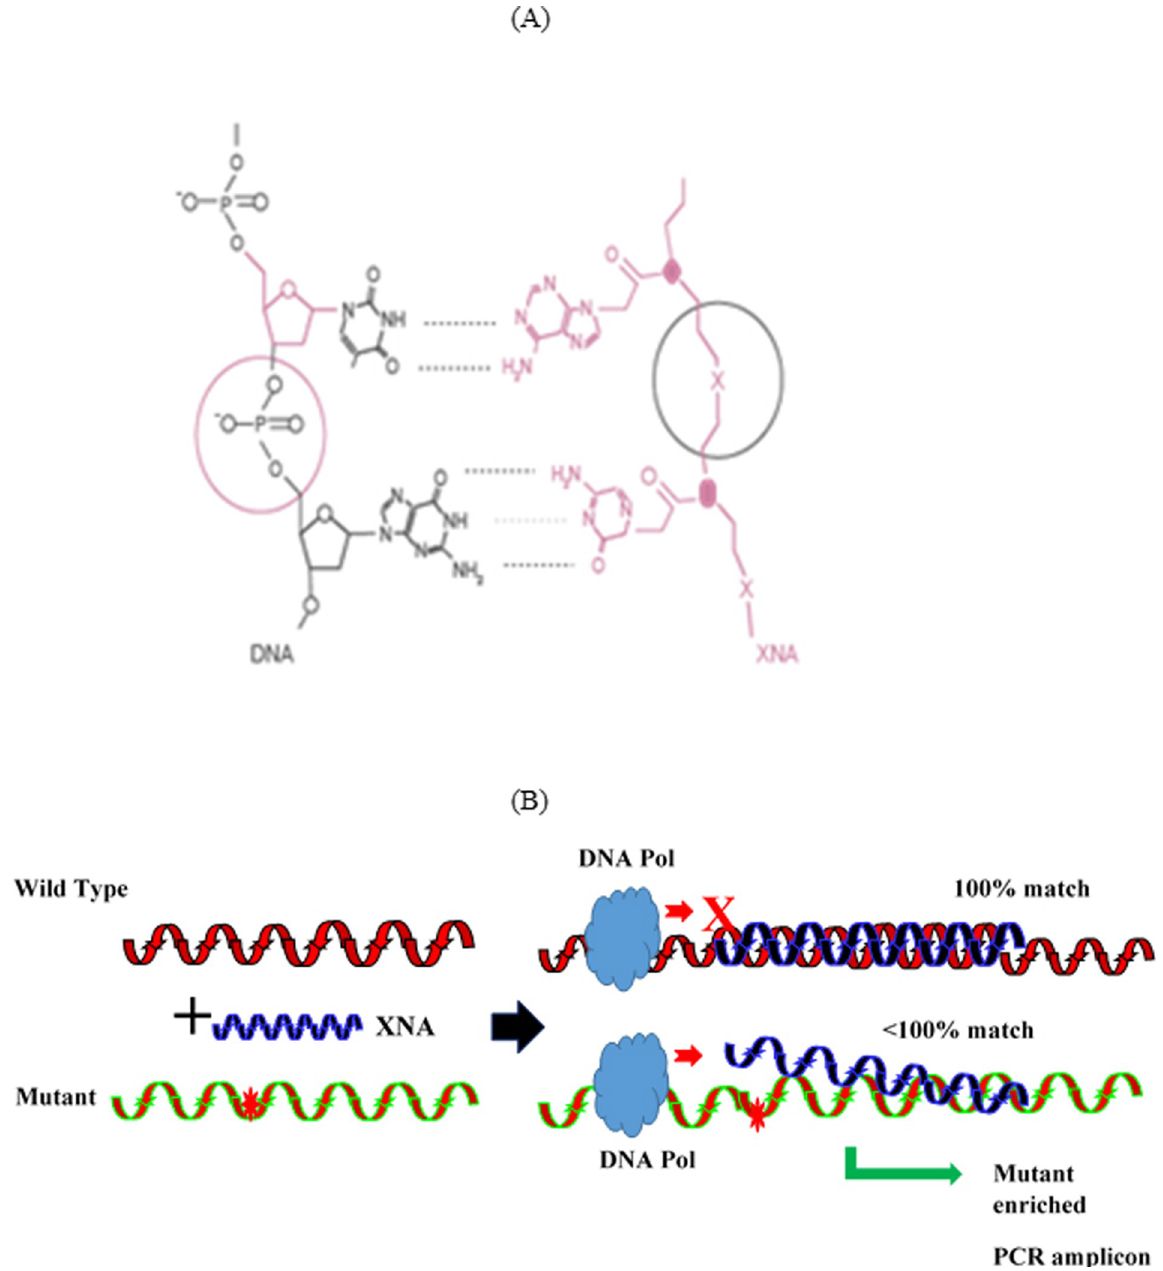
Fig 1. XNA structure and its function in the assay. (A). XNA structure and hybridization with DNA. (B). Principle of the Coloscape TM assay mutation detection in targeted genes. XNAs hybridize tightly to complementary DNA target sequences only if the sequence is a complete match. When there is a mutation in the target site, and therefore is a mismatch, the XNA: DNA duplex is unstable, allowing strand elongation by DNA polymerase. Addition of an XNA whose sequence is a complete match to the wild-type DNA to a PCR reaction blocks amplification of wild-type DNA allowing selective amplification of mutant DNA. This enrichment of the mutation amplicons enables mutation detection by